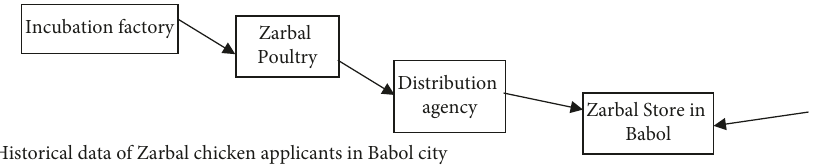
Figure 7: 4-level supply chain of Zarbal Company. Table 11: Forecasting the demand of agencies other than Babol city by the neural network